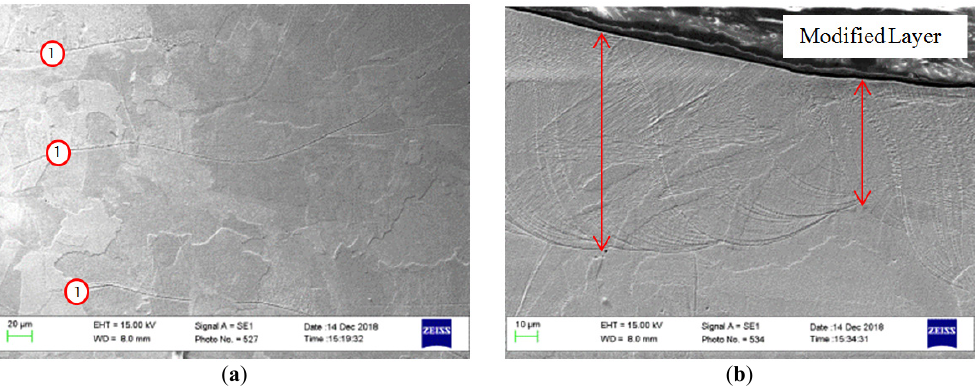
Figure 10. SEM micrograph of the cross-section of the ( a ) as-received and ( b ) re-melted modified layer